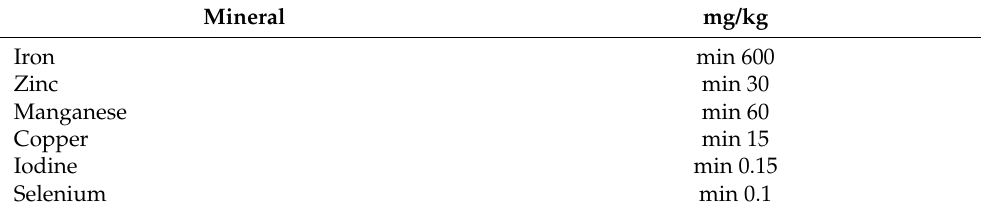
Table 6. Mineral composition of the rat diet used in the experiment.